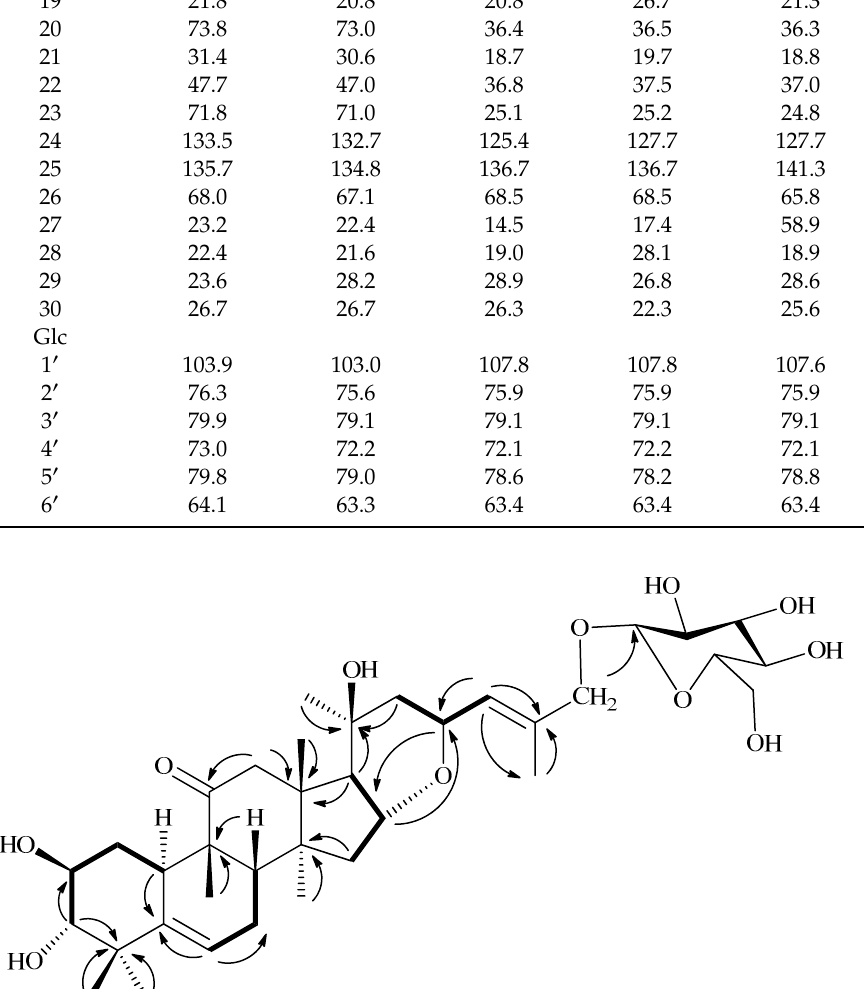
Table 1. 1 H-NMR Spectra Data (600 MHz, pyridine- d 5 ) for Compounds 1 – 5 ( δ H in ppm, J in Hz). Positio